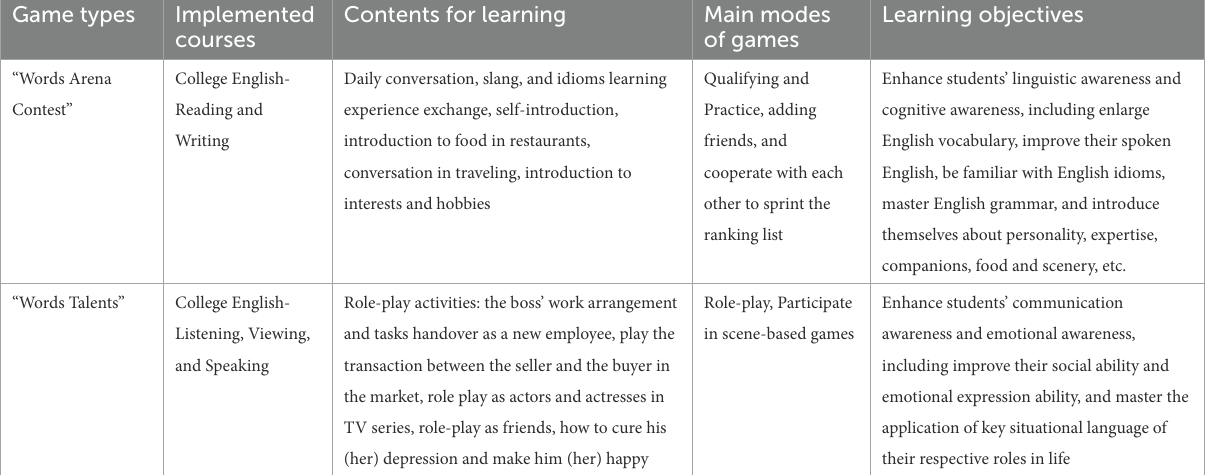
TABLE 1 The experimental design of game-based learning in “Digital Game-Virtual College” application. Game